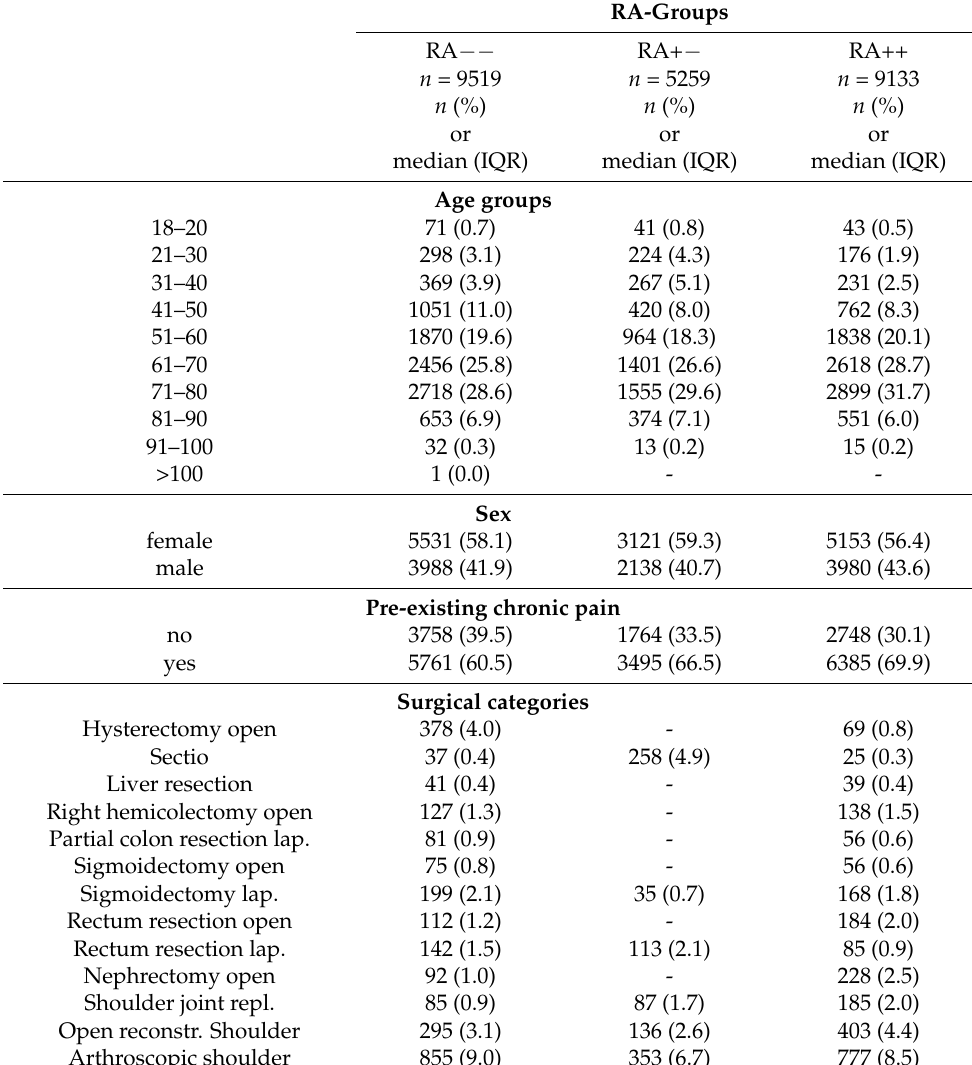
Table 1. Patients’